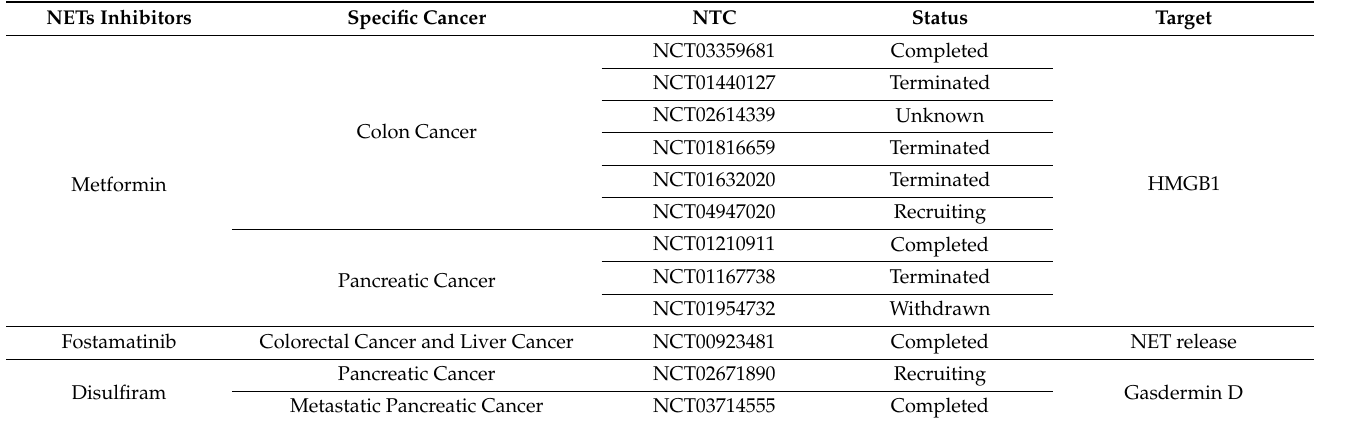
Table 2. Ongoing clinical trials in GI cancer patients with drugs that target the process of neutrophil extracellular trap (NETs)